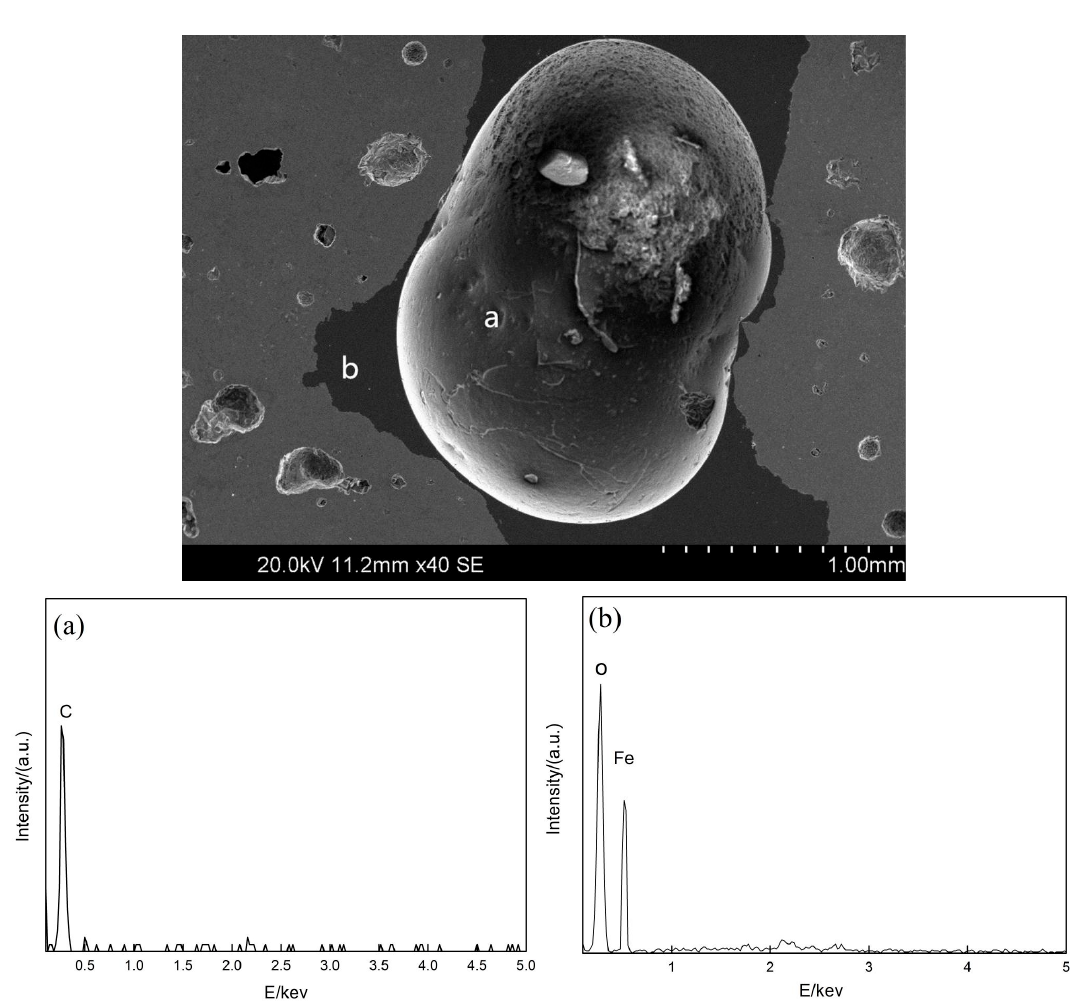
Figure 4. SEM photos of unburned coke in HCVTS. ( a ) EDS of point a; ( b ) EDS of point b.